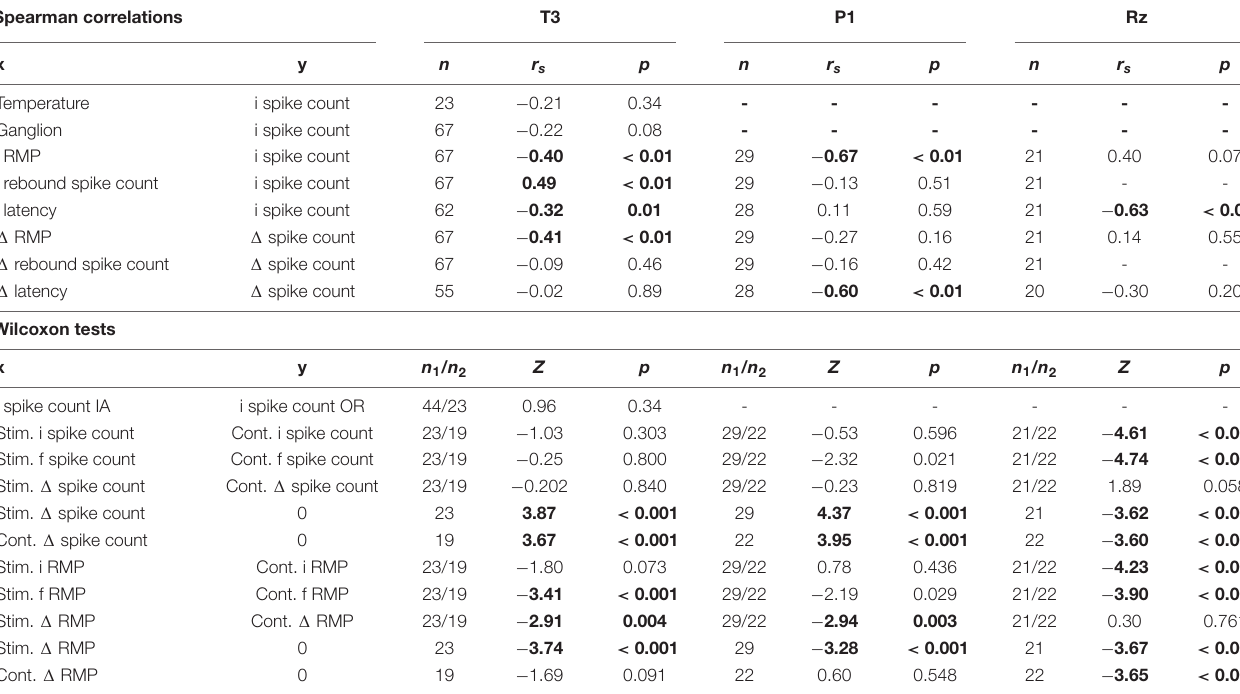
TABLE 1 | Interdependencies among outcome variables in T3 and P1 and Rz cells. Spearman